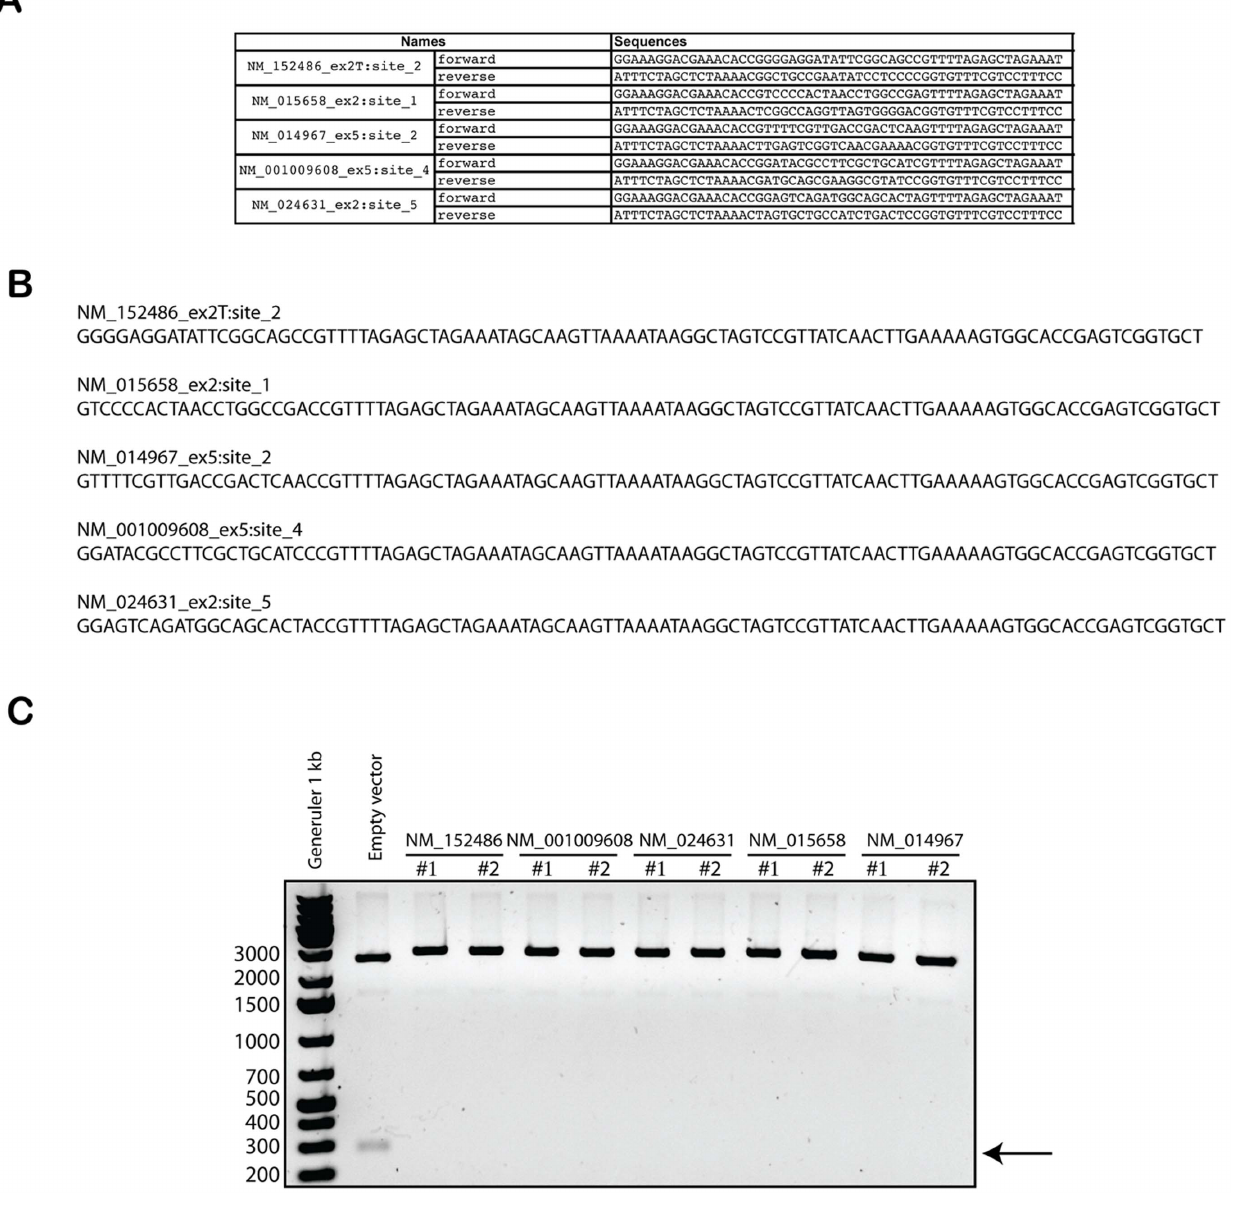
Figure 1. Fast PCR-based generation of sgRNA-encoding plasmids. ( A ) Table showing primers used to generate the sgRNA plasmids (pEsgRNA) for five different human ORFs using PCR-based insertion mutagenesis: NM_152486, NM_015658, NM_014967 (FAN1), NM_001009608 and NM_024631. ( B ) gRNA sequence transcribed from the U6 promoter. ( C ) sgRNA plasmids purified from bacteria were BamHI digested and separated using 1% agarose gel in TAE buffer. The arrow indicates the 300 bp BamH1 digest fragment.